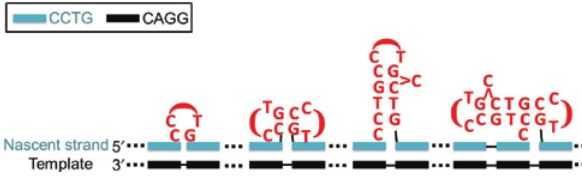
Figure 6: Multiple unusual CCTG structures can co-exist in the nascent strand.